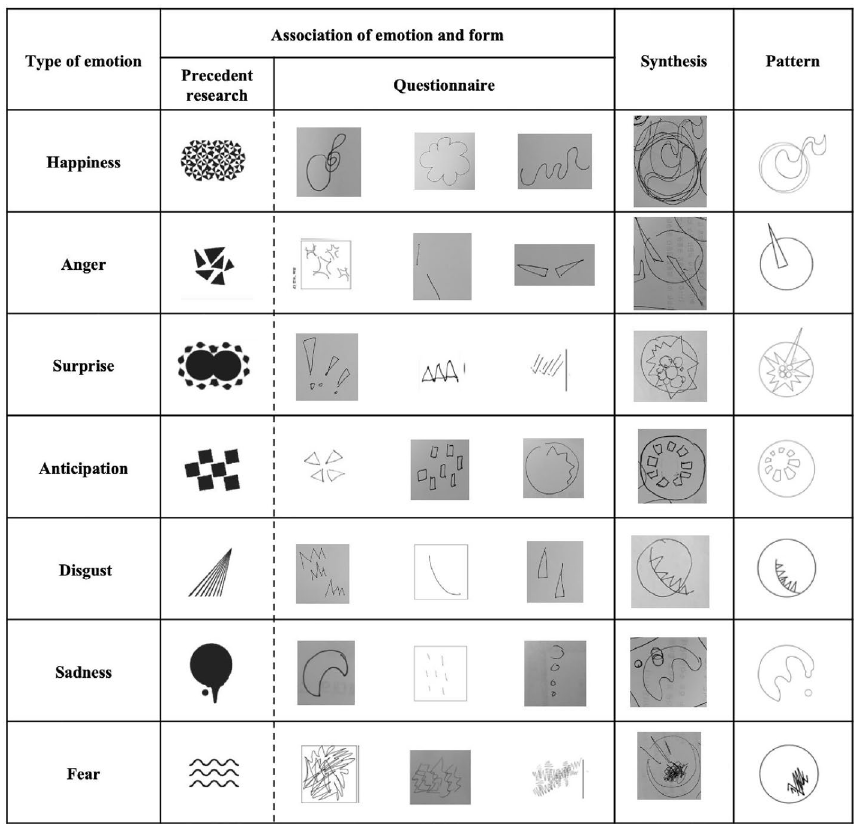
Table 2 The process of creating emotional